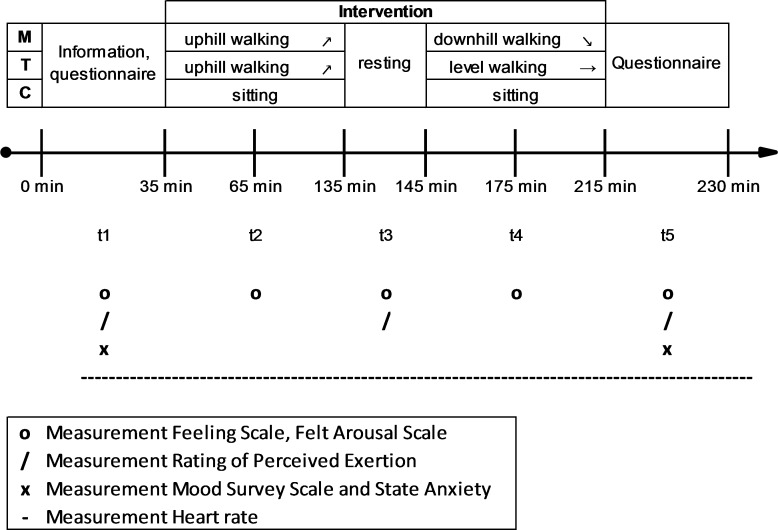
Sequence of events and timeline of conditions.M: outdoor mountain hiking, T: indoor treadmill walking, C: sedentary control condition.